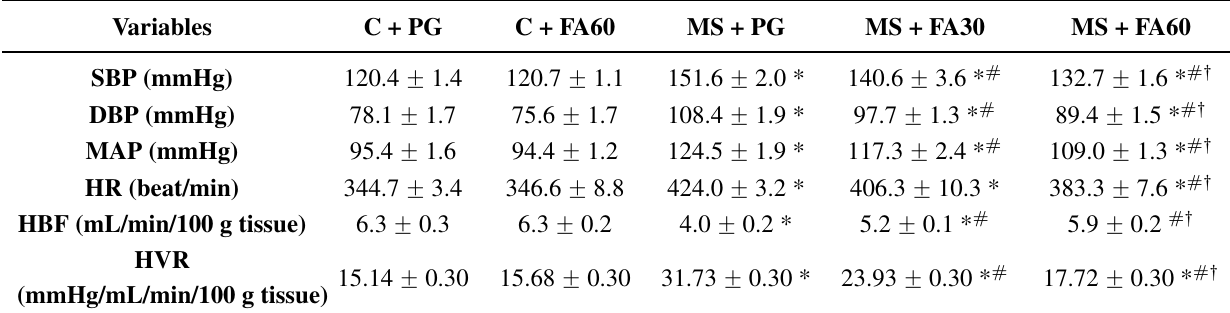
Figure 2. Effect of FA on systolic blood pressure in high carbohyrate and high fat (HCHF) induced high blood pressure. Normal control rats plus propylene glycol (solid circles), normal control rats treated with ferulic acid 60 mg/kg (open circles), MS rats plus propylene glycol (solid inverted triangles), MS rats treated ferulic acid 30 mg/kg (open triangles), MS rats treated with ferulic acid 60 mg/kg (solid squares). Each point represents the mean ± standard error of the mean (SEM) ( n = 10/group). * p < 0.05 vs. C + PG; # p < 0.05 vs. MS group; † p < 0.05 vs. MS with FA 30 mg/kg. FA, ferulic acid; MS, metablic syndrome; C + PG, normal control rats receiving ferulic acid. Table 4. Effect of FA on hemodynamic parameters in MS rats.